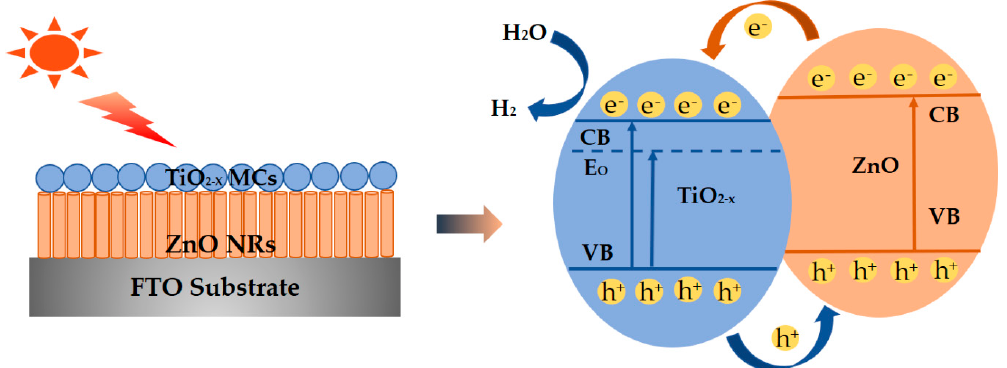
Figure 9. Mechanism model for the enhanced property of ZnO/TiO 2-X composite photocatalysts for the photocatalytic H 2 evolution reaction. photocatalytic H 2 evolution reaction.